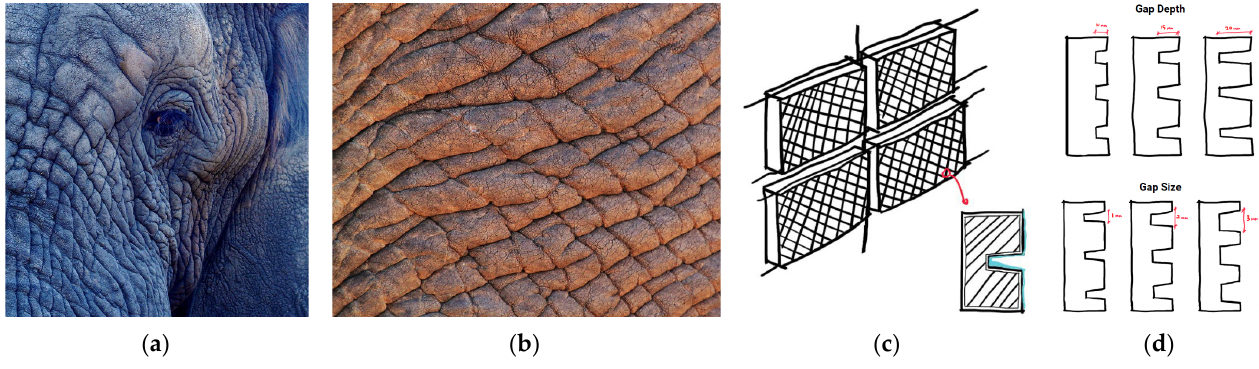
Figure 2. ( a ) Cracks on elephant skin. ( b ) Magnified view of cracks on the elephant skin. ( c ) Sketch mimicking the skin. ( d ) Sketch showing different widths and depths of the gaps for iterations. Photos: ( a ) Jennifer Latuperisa-Andersen Unsplash; ( c , d ) Photos: [24].